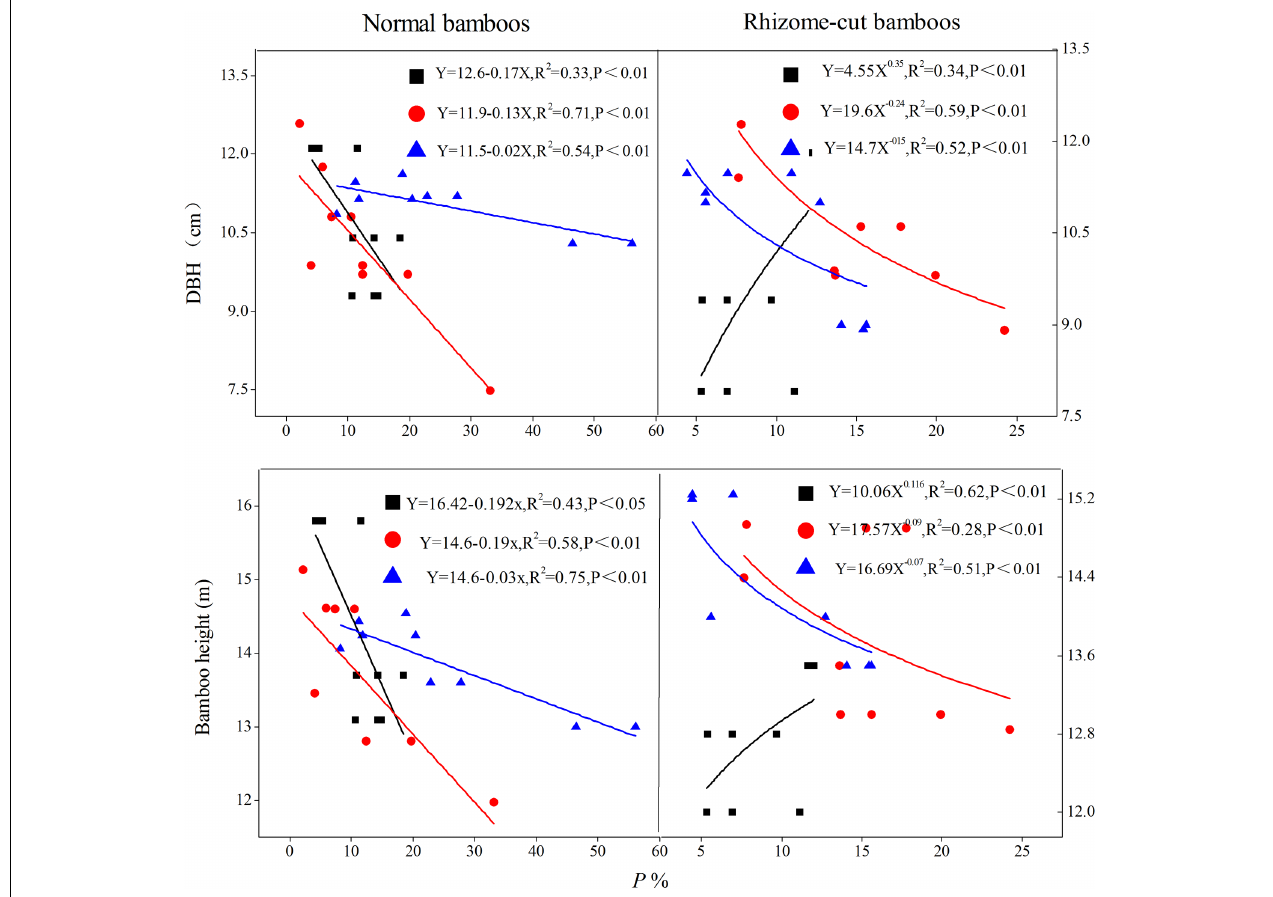
), and senescent bamboos ( (cid:78) ) in each (cid:32)